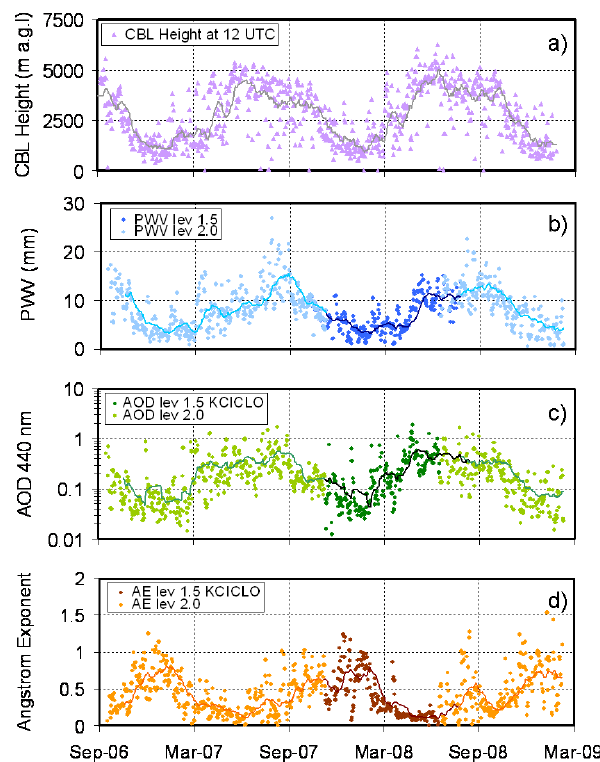
Figure 4. Time series of (a) CBL height (metres above ground level) determined from the 12:00UTC soundings (violet trian- gles) in Tamanrasset (reprinted from Guirado et al., 2011), and AERONET daily mean values of (b) PWV (mm), (c) AOD at 440nm, and (d) AE in the range 440–870nm (refer to legend for colour description). Solid lines correspond to 30-day moving aver- ages. AOD and AE are dimensionless